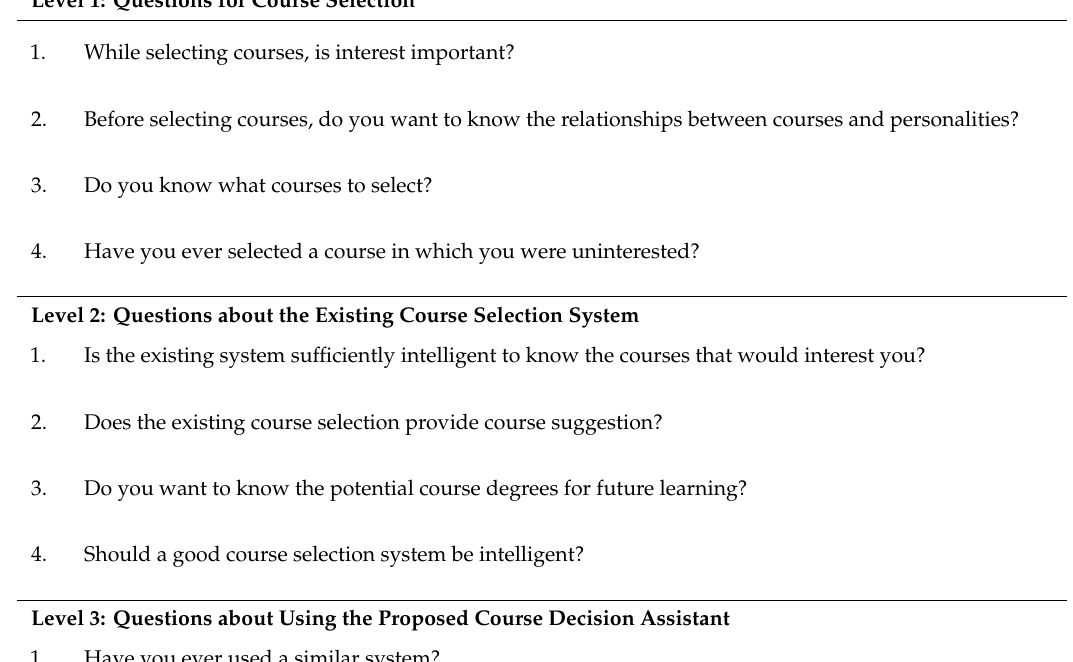
Table 5. Questionnaire for subjective